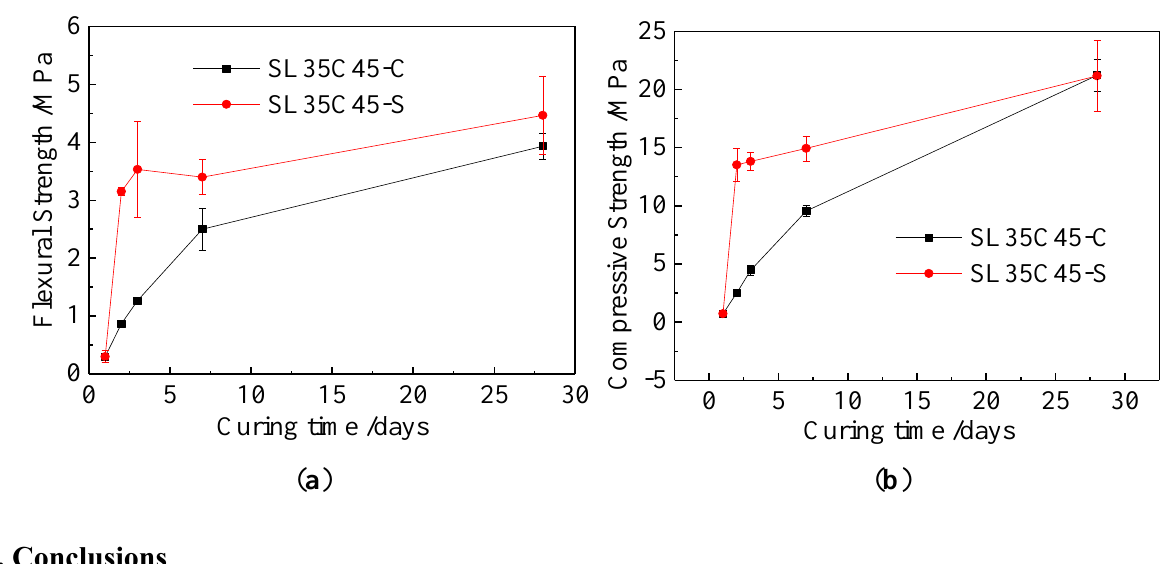
Figure 4. Effect of curing conditions on strength of Class F fly ash-slag geopolymer mortar. ( a ) Flexural strength; and ( b ) compressive